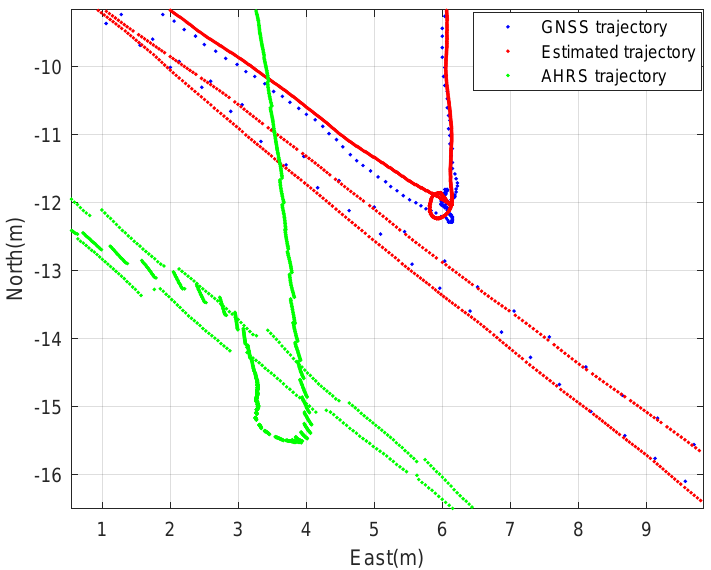
Figure 20. The expanded 2D trajectory of the athlete: comparison with Microstraion’s AHRS. Figure 21 shows the three-axis velocities of the athlete for the comparison experiment. The green lines are the estimated three-axis velocities obtained from Microstrain’s 3DM- GX5 GNSS/IMU AHRS and the red lines are the estimated three-axis velocities using the designed integration filter of the wearable EPTS. The estimated results and the high- precision GNSS/IMU AHRS results are similar as shown in Figure 21.